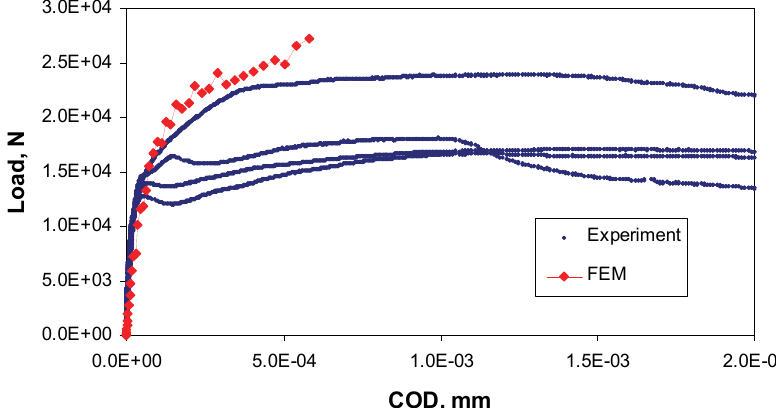
Figure 10: Load-crack opening displacement diagram of a four point bending test for steel fiber reinforced concrete. Numerical and experimental